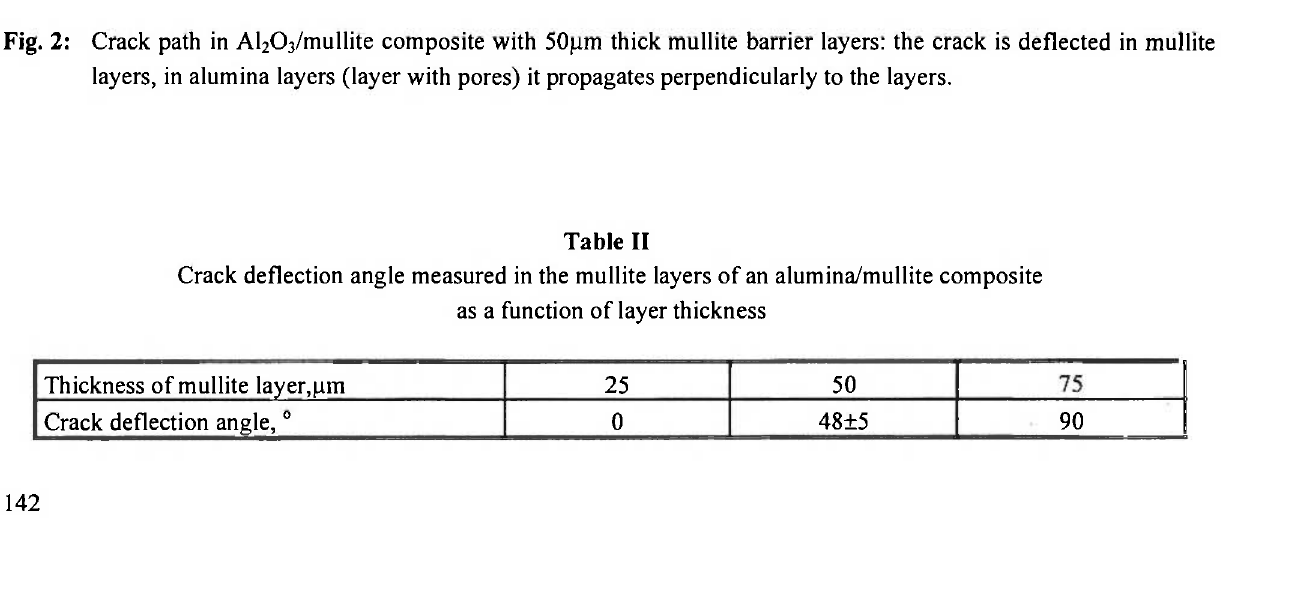
Thickness of mullite layer,μιτι Crack deflection angle,